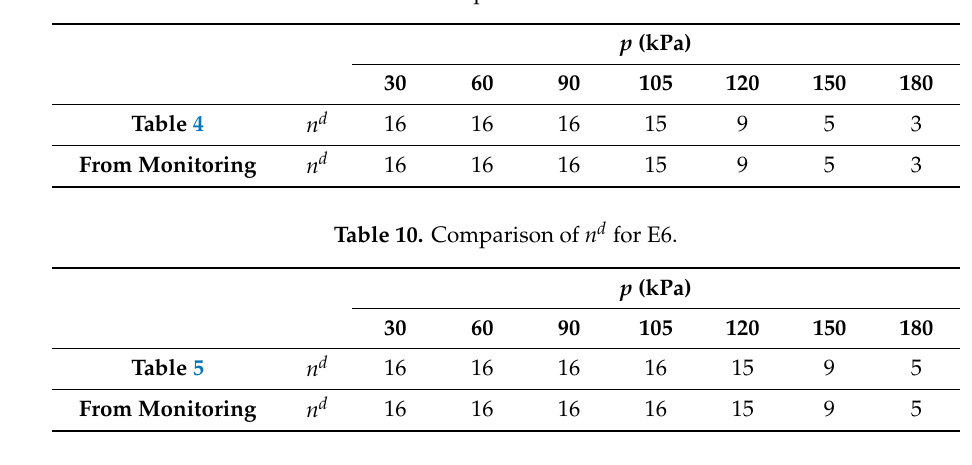
Table 9. Comparison of n d for E9.